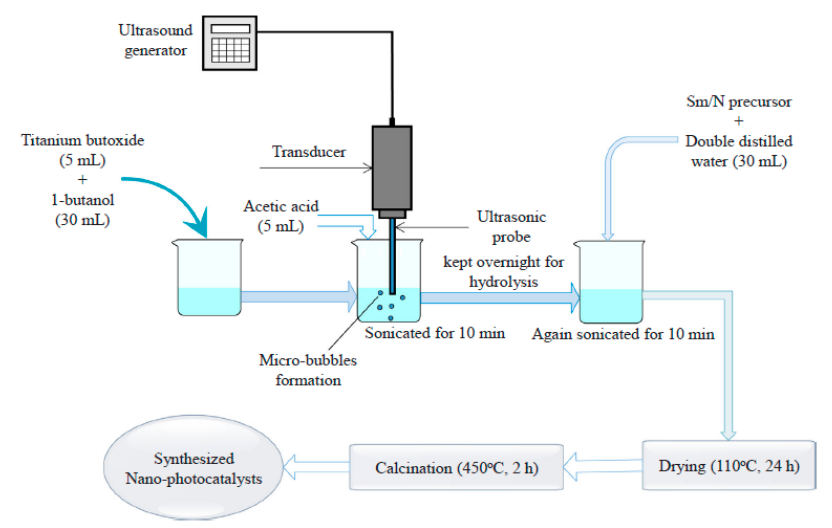
Figure 8. Schematic illustrating the ultrasound assisted sol-gel synthesis process of the Sm/N doped TiO 2 . Adapted with permission from Reference [58]. Copyright (2019) Elsevier.